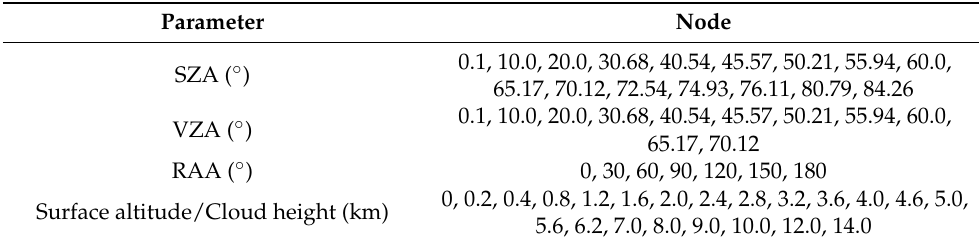
Table 1. Parameter node settings of the look-up table (LUT).